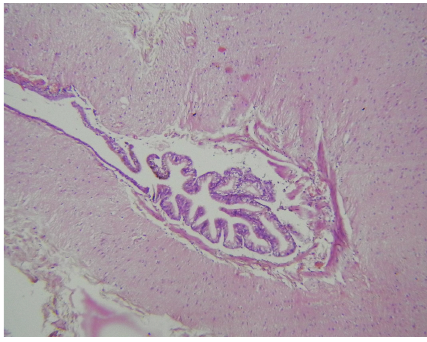
Figure 3: Section from the tumor showing intestinal type glands surrounded by cerebral parenchyma, H & E 10X objective.